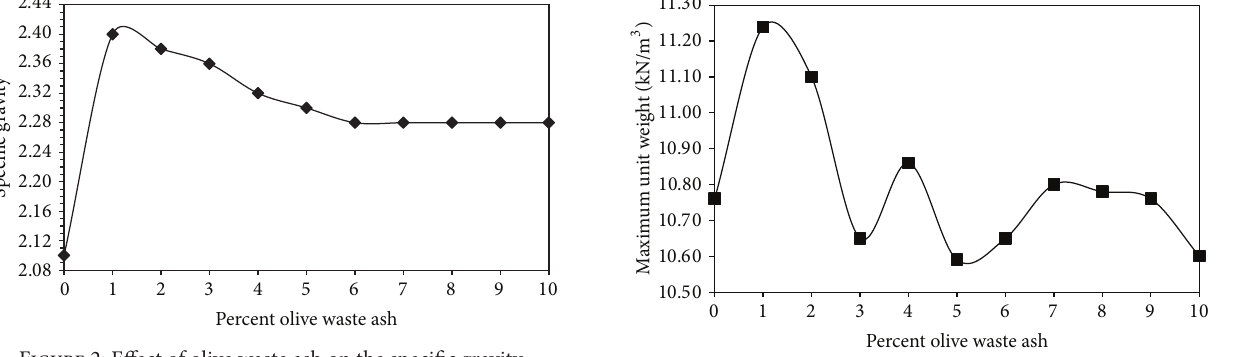
Figure 4: Effect of olive waste ash on the maximum dry unit weight.